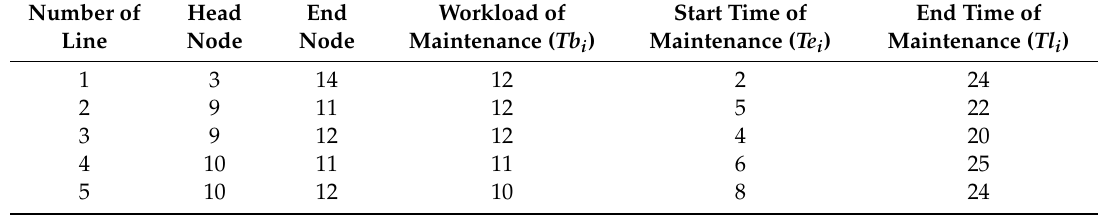
Table 2. Information of the transformer to be maintained.